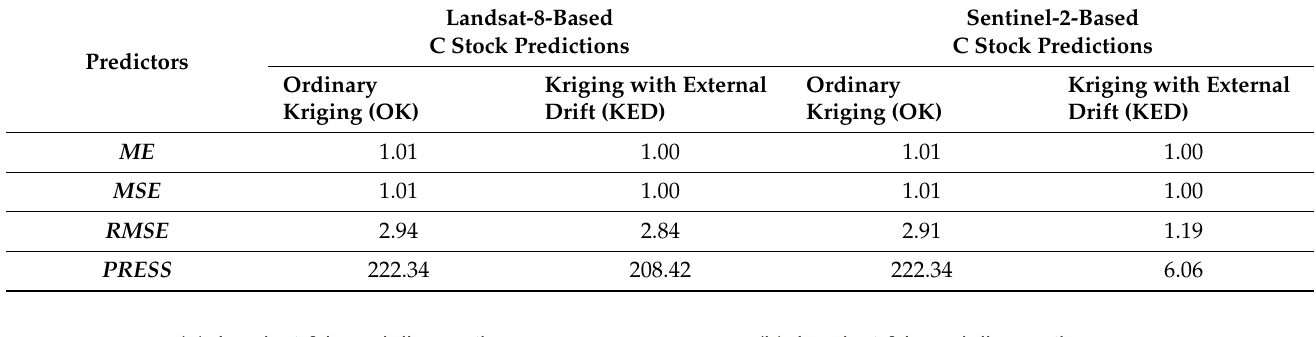
Table 5. Frequentist geostatistical C stock prediction validation statistics.